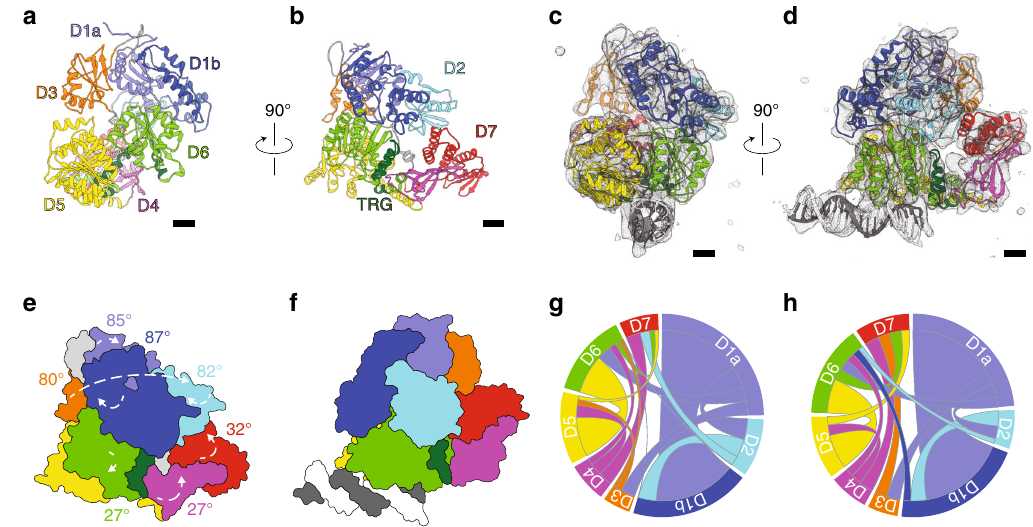
Fig. 3 Cryo-EM reconstruction of dsDNA-bound Mfd reveals a mobile D3 module and the interaction of dsDNA with the motor lobes. a , b Orthogonal views of nucleotide-free Mfd (PDB ID 2EYQ). Scale bar is equivalent to 10 Å. c , d Orthogonal views of the cryo-EM reconstruction (gray surface) with the fi tted Mfd model shown as a cartoon and colored as in a. DNA is shown in gray. e , f Cartoons of Mfd structures in the nucleotide free e and DNA-bound form f after superposition on the C α trace of D5 and highlighting the relative rotation of Mfd domains in the free and tight DNA-bound state. g , h Chord plots highlighting intramolecular rearrangements in Mfd before g and after h DNA binding. In all panels, Mfd is colored by domain as in Fig. (Fig. 2d – f) becomes fully exposed. Contacts of D2 with conserved residues in D7, D0148, and F1050 are lost.